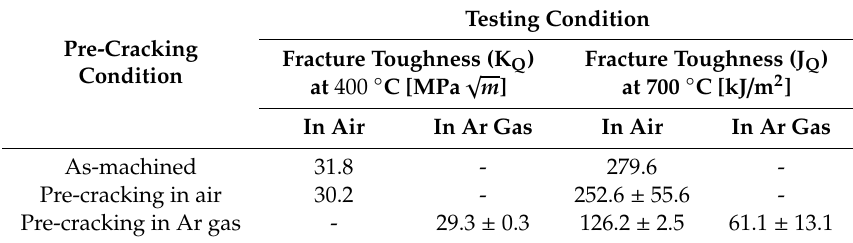
Figure 5. ( a ) The results of fracture toughness test at room temperature (RT) and 400 ◦ C and ( b ) the load-displacement curves for specimens tested at 400 ◦ C. Table 3. Fracture toughness of DFW under di ff erent pre-cracking and testing